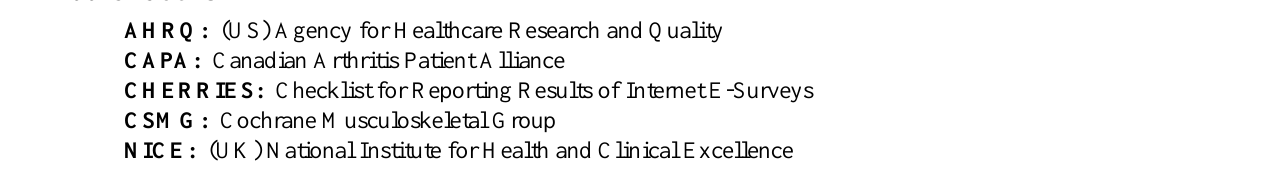
CSMG: Cochrane Musculoskeletal Group NICE: (UK) National Institute for Health and Clinical